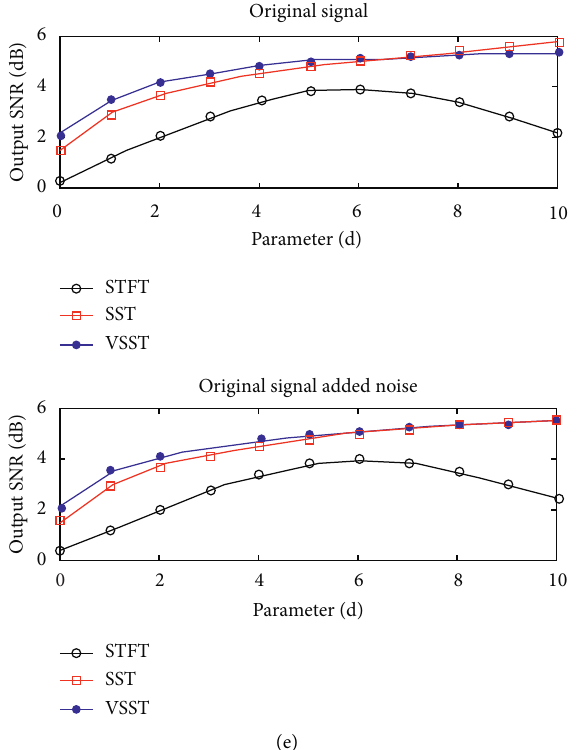
Figure 10: Output signal-to-noise ratio (SNR) for original signal (top) and original signal with added noise (bottom) under different working conditions: (a) fault-free, (b) inner race fault, (c) outer race fault, (d) ball fault, and (e) combined fault of inner and outer